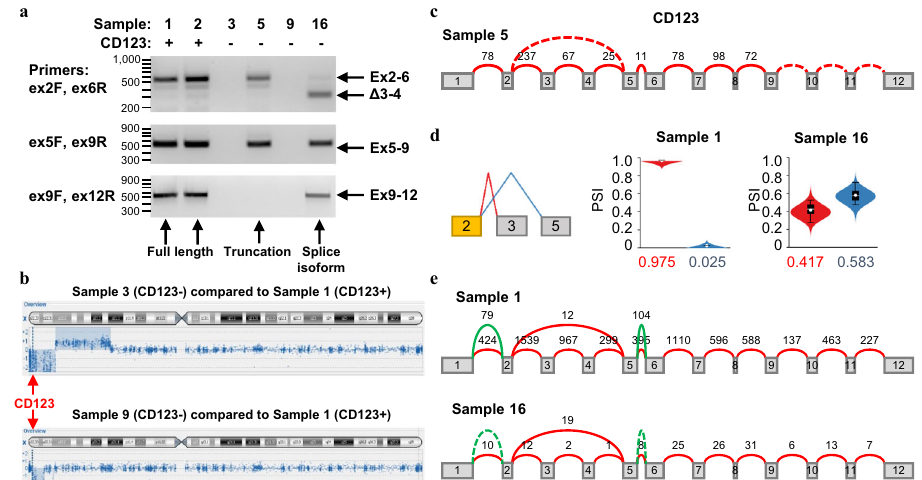
Fig. 6 Molecular analysis of CD123 loss following UCART123 treatment. a RNA was isolated from 2 CD123 + samples from the vehicle-treated group (samples 1 and 2) and 4 CD123 - samples from the UCART123-treated group (samples 3, 5, 9 and 16). RT-PCR performed with primer pairs spanning the entire CD123 transcript detected full-length CD123 RNA (samples 1 and 2), truncated C123 RNA (sample 5), spliced CD123 isoforms (sample 16), or absence of CD123 mRNA (samples 3 and 9). Each RT-PCR experiment was repeated twice, on different dates, with essentially identical results. 100 bp DNA Ladders were used as molecular weight markers. Uncropped and unprocessed scans can be found in the Source Data fi le. b aGCH analysis performed on samples 3 (upper) and 9 (lower) showed a large genetic deletion on chromosome X, compared to CD123 + samples, corresponding to the location of CD123. c A Majiq-generated splice graph shows no exon junction reads for exons 9 – 12 of CD123 in sample 5. d Majiq-generated violin plots show the predominant splicing of exon 2 to exon 3 (red) in control (CD123 + ) samples but an increase in skipping from exon 2 to exon 5 (blue) in sample 16. The 95% con fi dence interval in this context is de fi ned as follows: given observed reads in both experiments there is a 95% posterior probability that there is a change of 20% or more in percent-spliced-in (PSI). e A Majiq-generated splice graph shows increased skipping of exons 3 – 4 in sample 16 (lower panel) compared to control CD123 + samples (upper panel). Source data are provided as a Source data fi results showed that, compared to sample 1 (CD123 + ), samples 3 premature transcription termination. Interestingly, if translated, and 9 (CD123 - ) had large regional deletions on chromosome X, this truncated transcript would produce a protein isoform lacking which includes the CD123 gene (Fig. 6b). In another CD123 - the transmembrane domain in exon 10 (Fig. 6c and Supple- sample (sample 5), the splicing analysis algorithm MAJIQ 19,20 mentary Fig 13b). Finally, MAJIQ also revealed canonical splicing detected CD123 transcripts containing only exons 2 – 9, indicating of exon 2 to exon 3 in all CD123 + samples but a sharp increase in